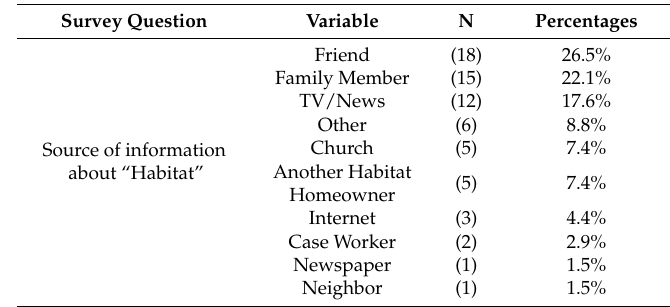
Table 11. Responses to the question ‘How did you learn about Houston Habitat for Humanity?’.